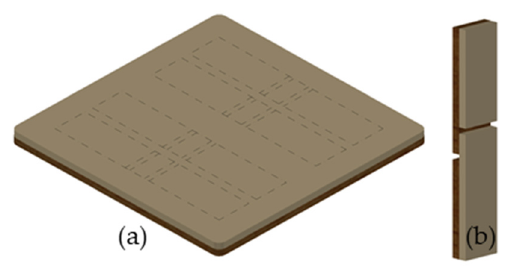
Figure 2. Schematic of the overmolded solid wood ( a ) and representation of the specimens for the tensile shear strength σ S ( b ) according to ÖNORM EN 302-1 [34]. sile shear strength σ S ( b ) according to ÖNORM EN 302-1